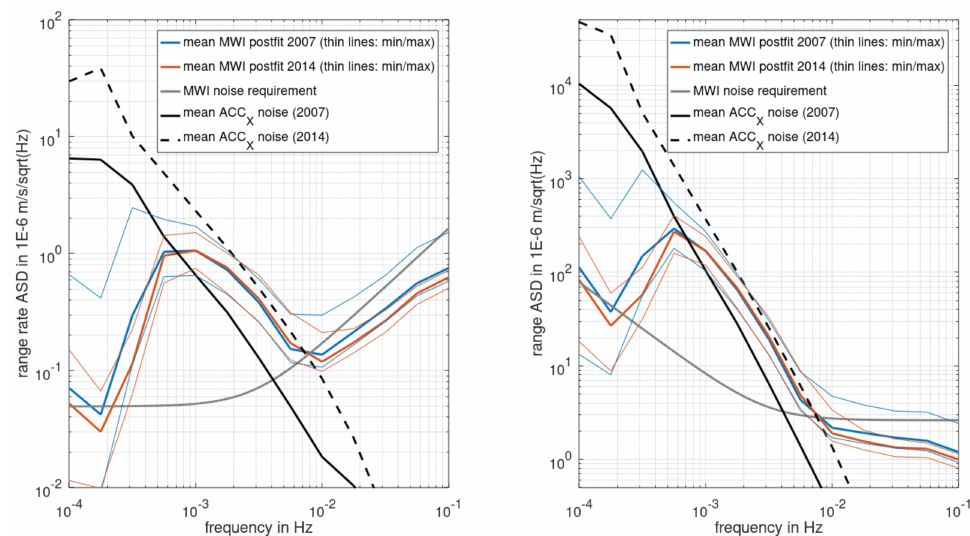
Figure 3. Mean annual smoothed MWI post-fit residual ASDs for 2007 (blue, thick lines are the mean; thin lines the min/max) and 2014 (orange) in terms of range rates ( left ) and ranges ( right ), in comparison with the MWI noise requirements and the mean along-track ACCX noise for 2007 (solid black, cf. Figure 4, left) and 2014 (dashed black).